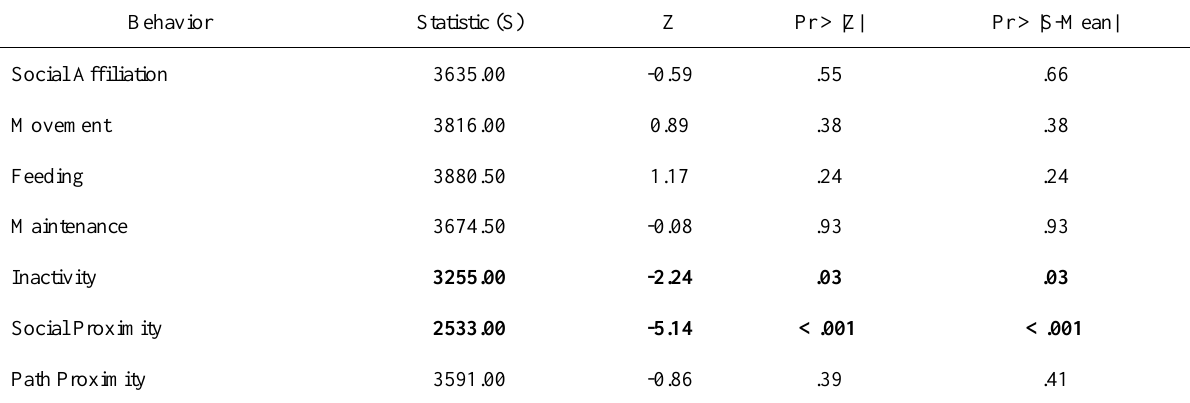
Wilcoxon Two-Sample Tests with Monte Carlo Correction Results for Behavioral Variation Between Zoo Status Conditions